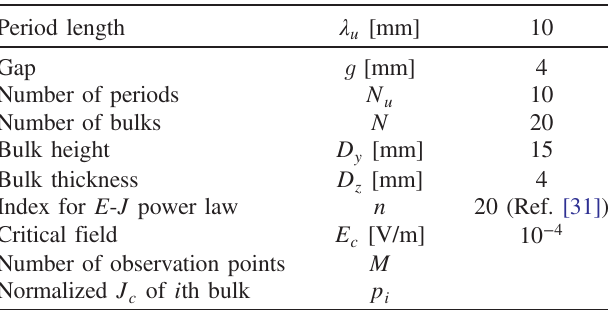
TABLE I. Parameters and variables used in the